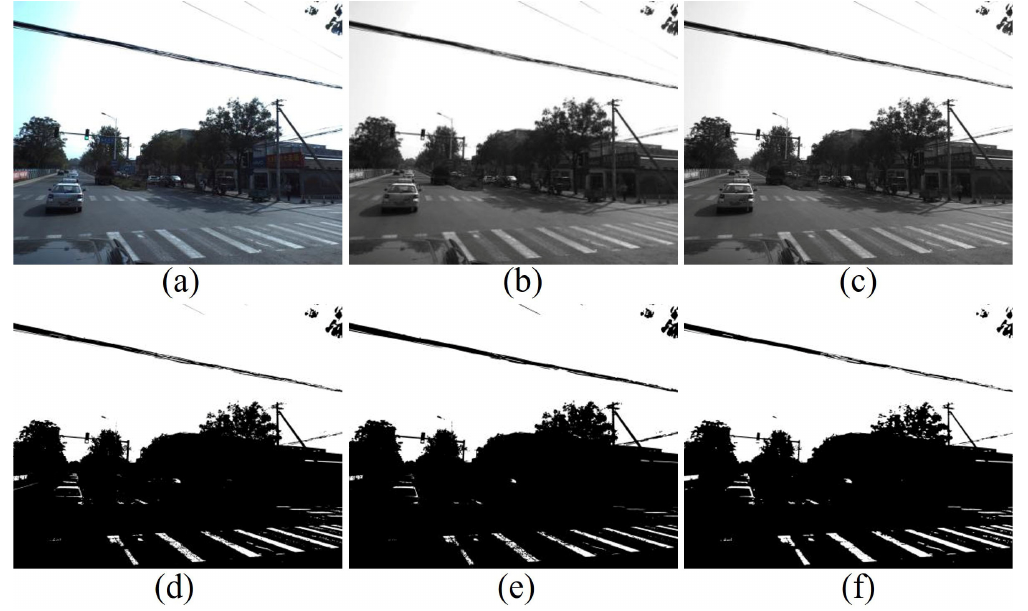
Figure 10. The comparison of origin image ( a ), grayscale image ( b ), grayscale image after Gaussian filtering ( c ), binarization image ( d ), binarization image after erosion ( e ) and binarization image after dilation ( f ).